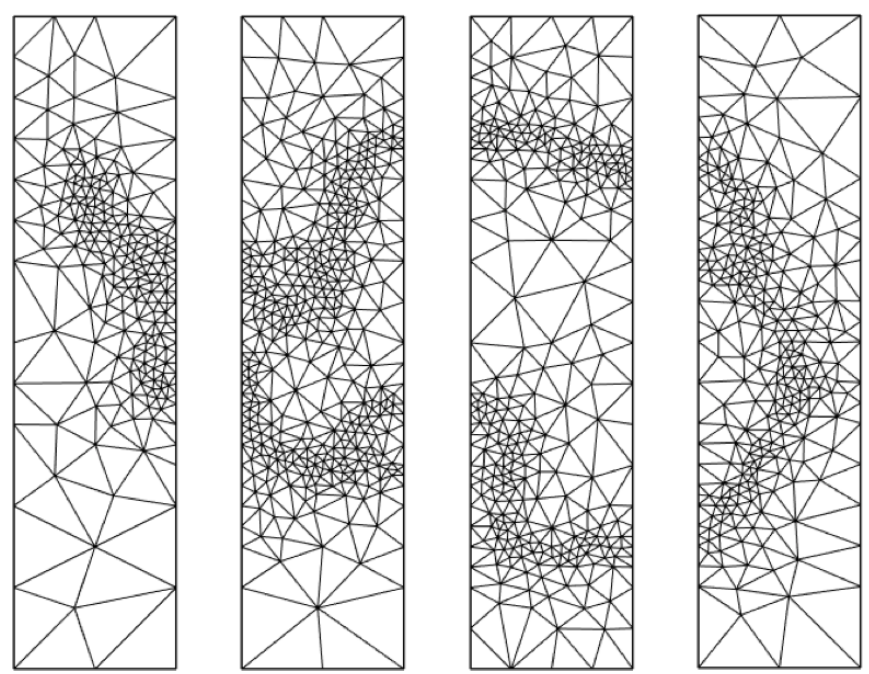
Figure E2. Four Antarctic submeshes that will be merged into a single, domain-wide mesh.